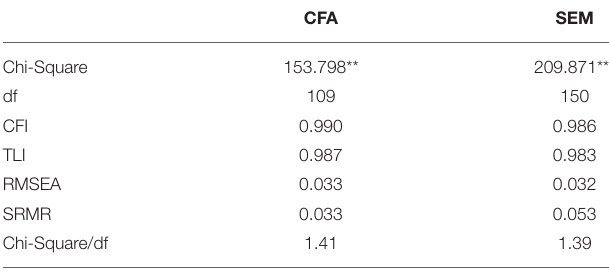
TABLE 3 | Goodness of fit indexes of confirmatory factor analysis (CFA) and structural equation modeling (SEM) for the tested model.